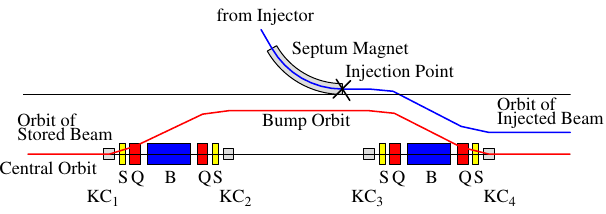
FIG. 1. (Color) Schematic drawing of a conventional injection scheme. After the injected beam is bent into the orbit by the septum magnet, the injected beam is perturbed by two kicker and KC ; it then oscillates with a large amplitude magnets KC 3 4 in the ring. For the stored beam, the pulsed bump orbit is , KC , KC , and KC . produced by four kicker magnets KC 1 2 3 4 B, Q, and S denote the bending, quadrupole, and sextupole magnets, respectively. The cross represents the injection